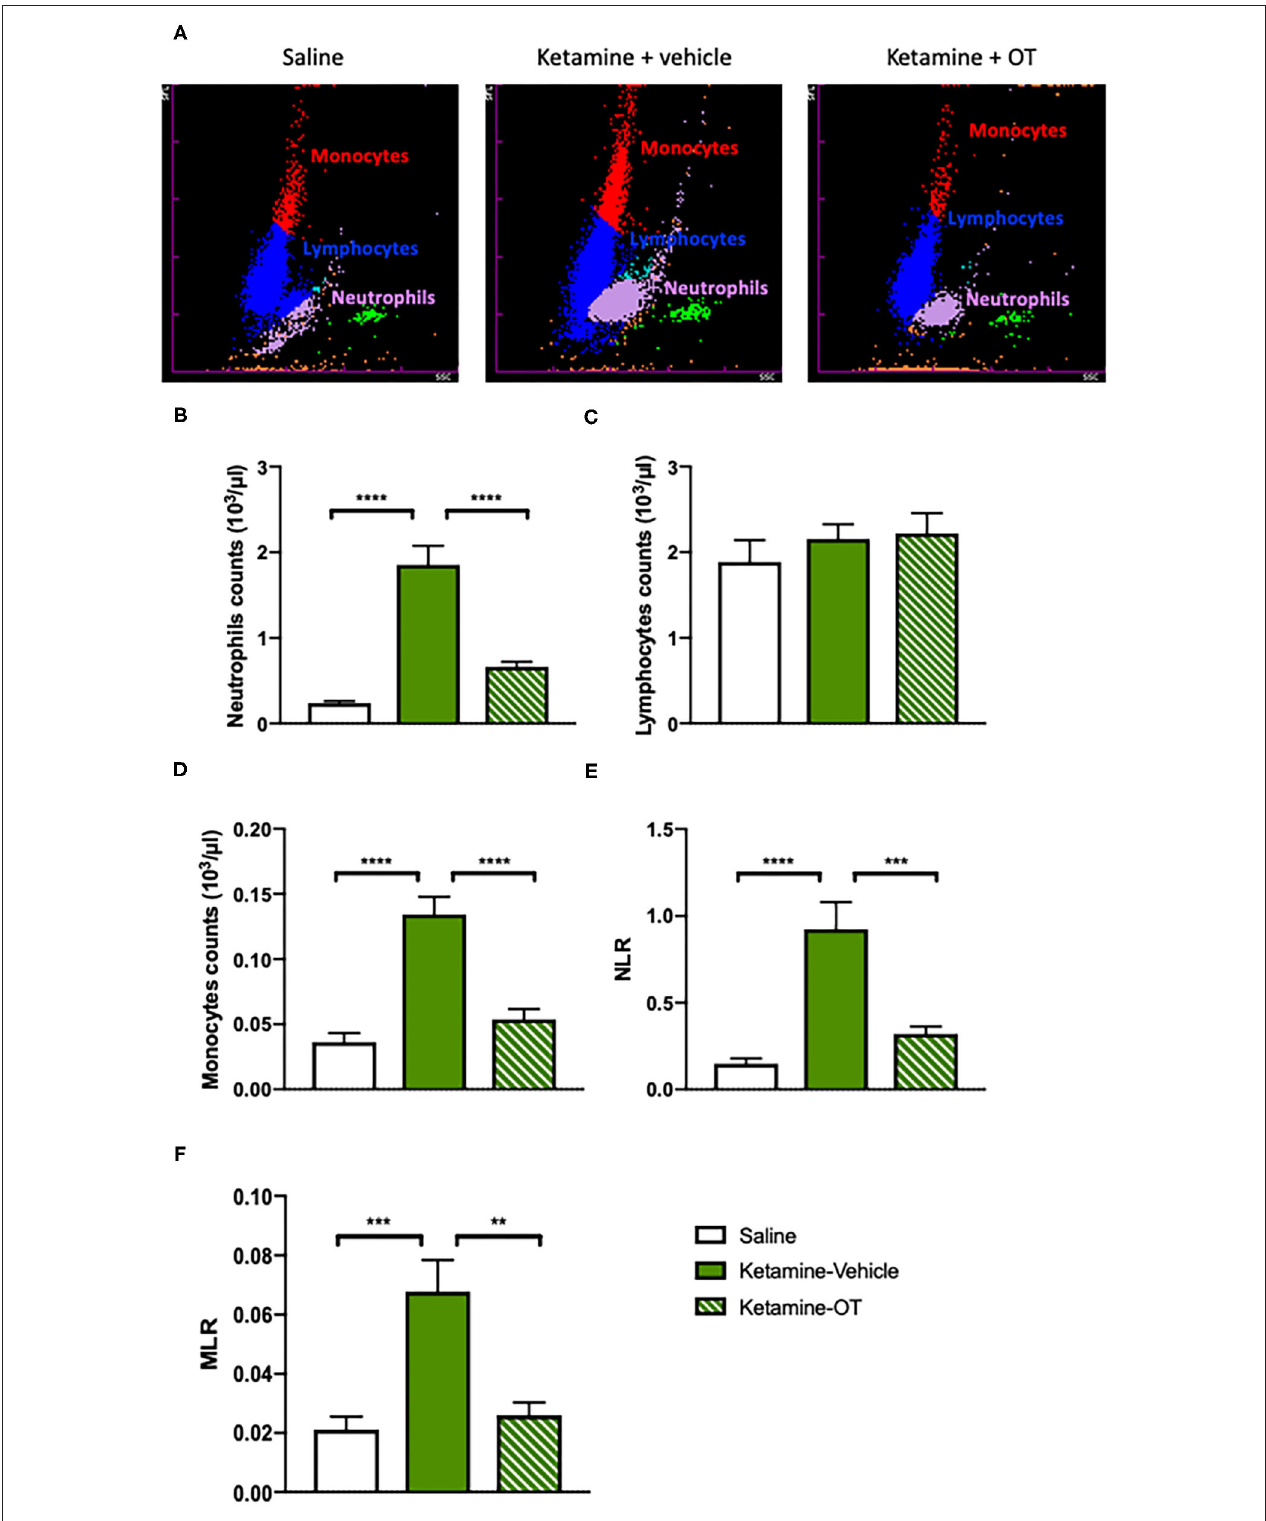
FIGURE 5 | mPFC oxytocin regulates the blood immune markers in ketamine-treated mice. (A) The representative images from hematology analyzer showing neutrophils, lymphocytes, and monocytes. (B) The count of blood neutrophils, (C) lymphocytes, (D) monocytes, (E) NLR, and (F) MLR. Data are presented as mean ± SEM. ** p < 0.01, *** p < 0.001, **** p < 0.0001, compared with saline or ketamine-vehicle group. n = 8–9 per group. NLR, the neutrophil to lymphocyte ratio; MLR, the monocyte to lymphocyte ratio; OT, oxytocin.